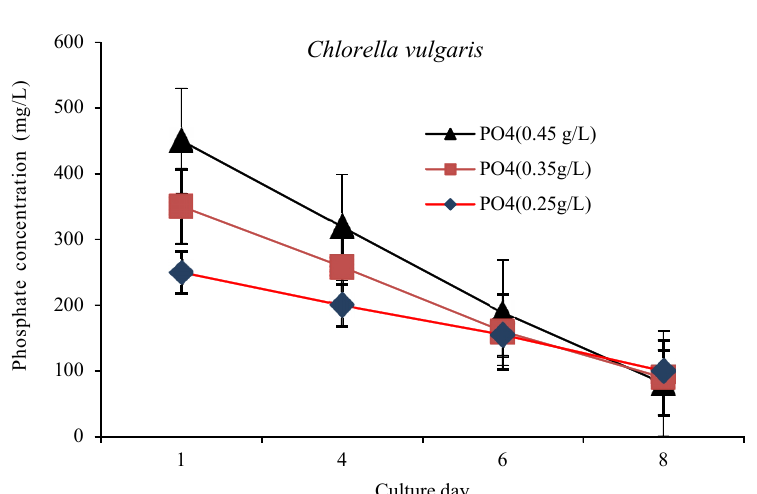
Fig. 3: Comparing the mean and standard deviation of remaining phosphate treatments